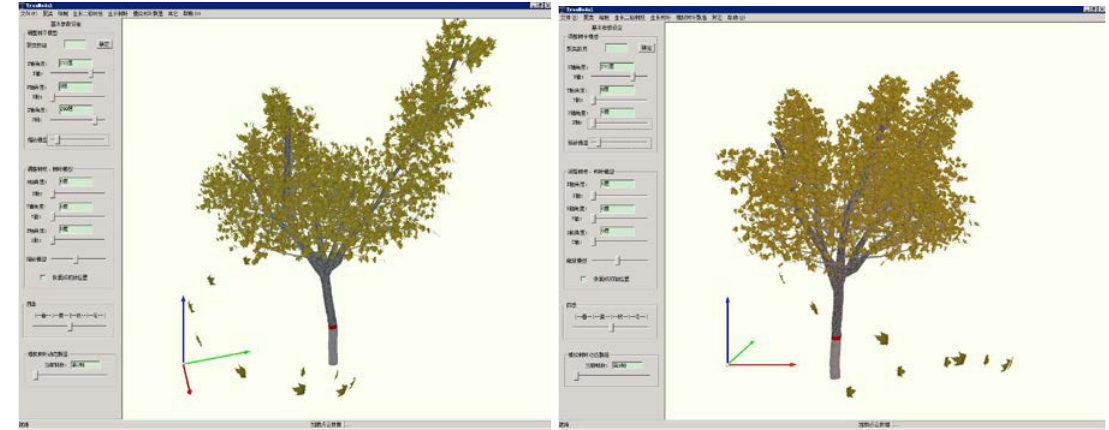
Figure 7. Two angles of screw roll